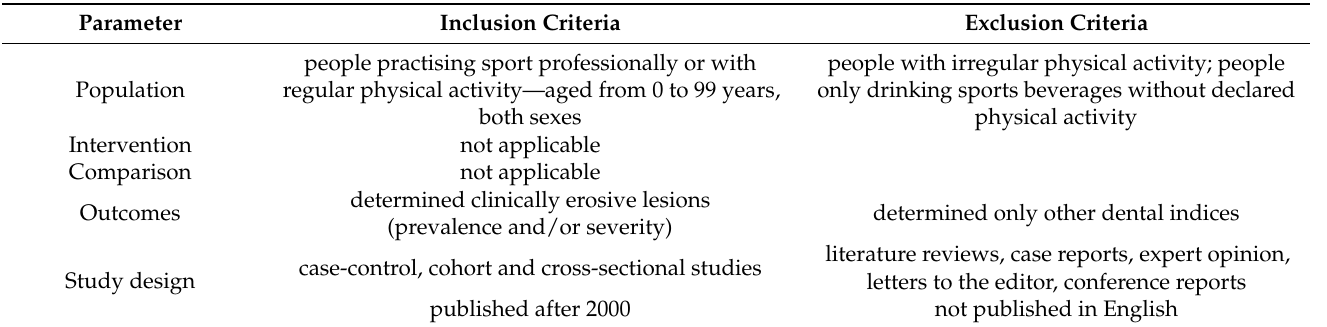
Table 1. Inclusion and exclusion criteria according to the